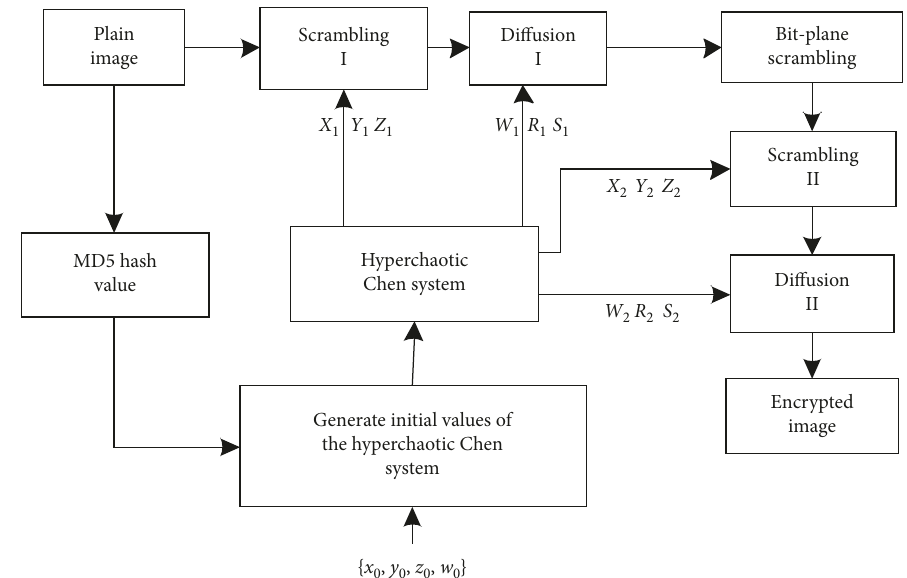
Figure 2: Image encryption